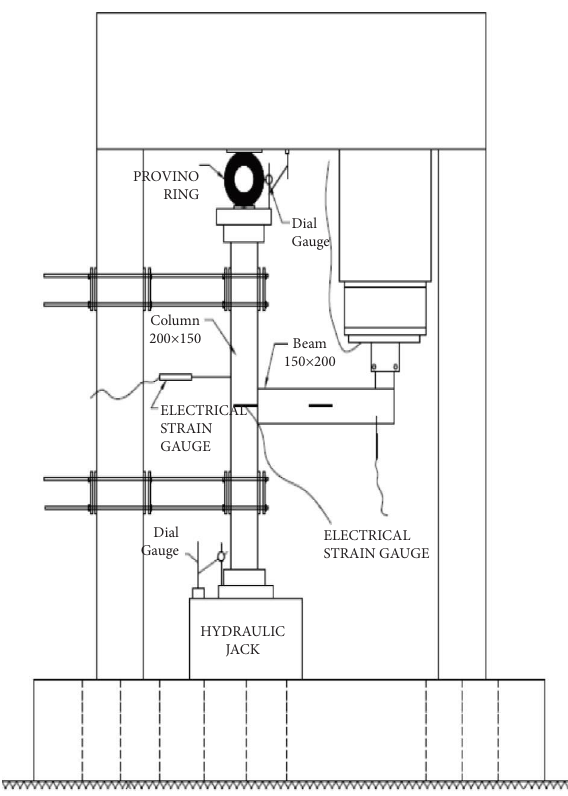
Figure 2: Experimental test